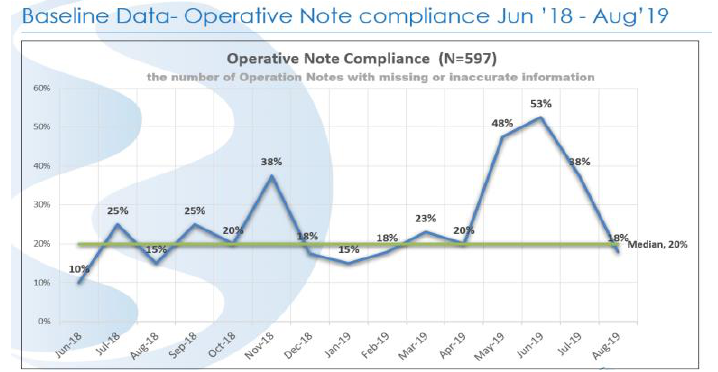
Figure 1. The number of ONs with missing or inaccurate information .